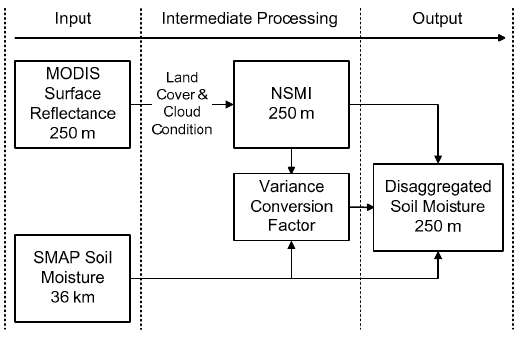
Figure 2. Algorithm flow of the NIR-red spectra-based disaggregation (NRSD) method.